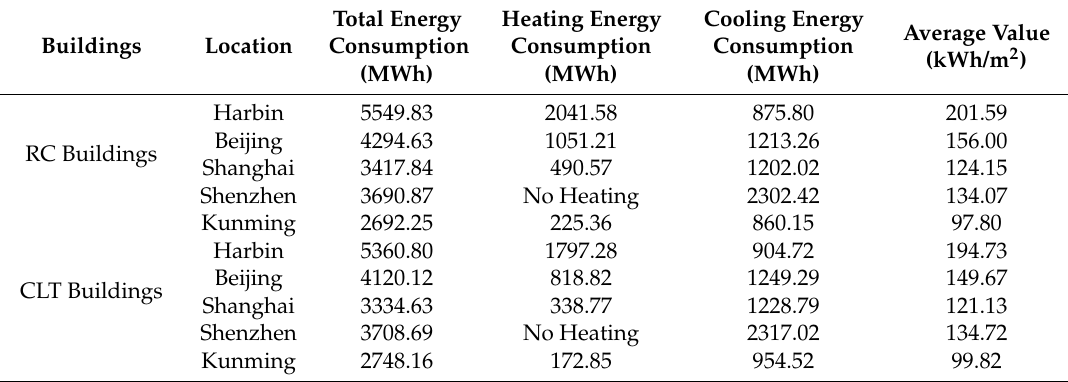
Table 14. Simulation results of building energy consumption during operation stage per